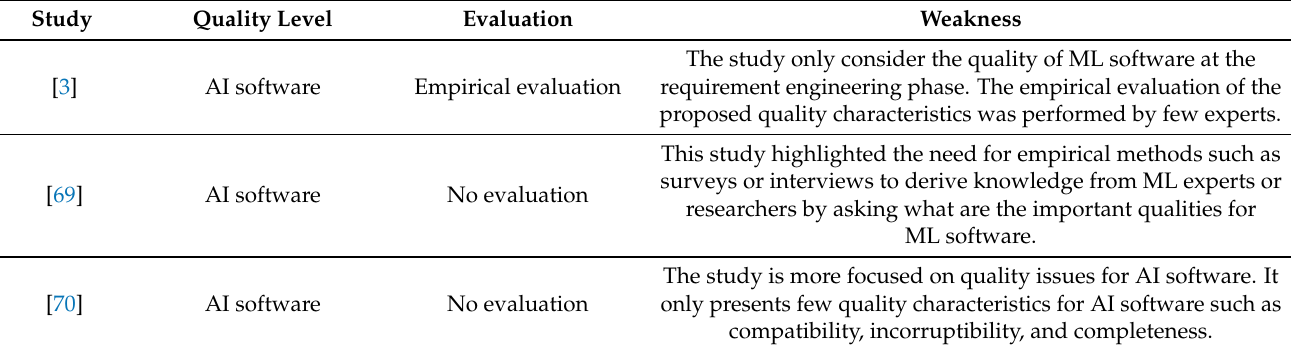
Table 5. Existing Quality Models for AI